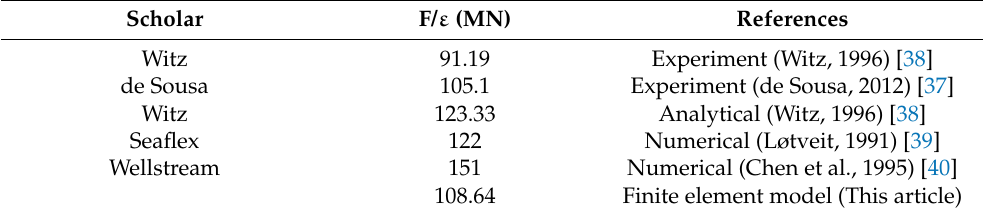
Table 4. Axial tensile stiffness obtained by different